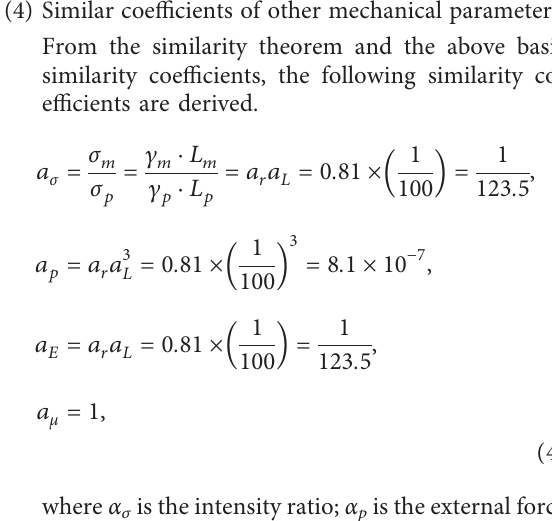
Figure 2: The engineering geological section of five-nine exploration line of the north mining area of the second pithead of Jinning Phosphate